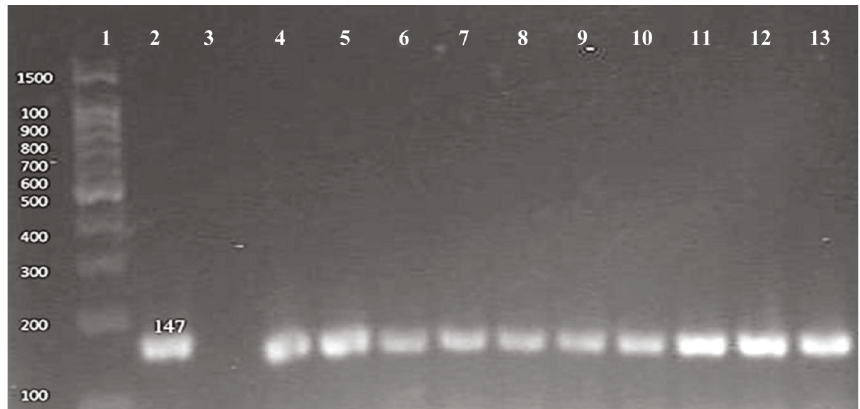
Figure 1: Molecular conformation of E. coli by uidA gene. Number 1: 100bp DNA ladder; number 2: positive control; number 3: negative control; number 4 to 13: positive samples.